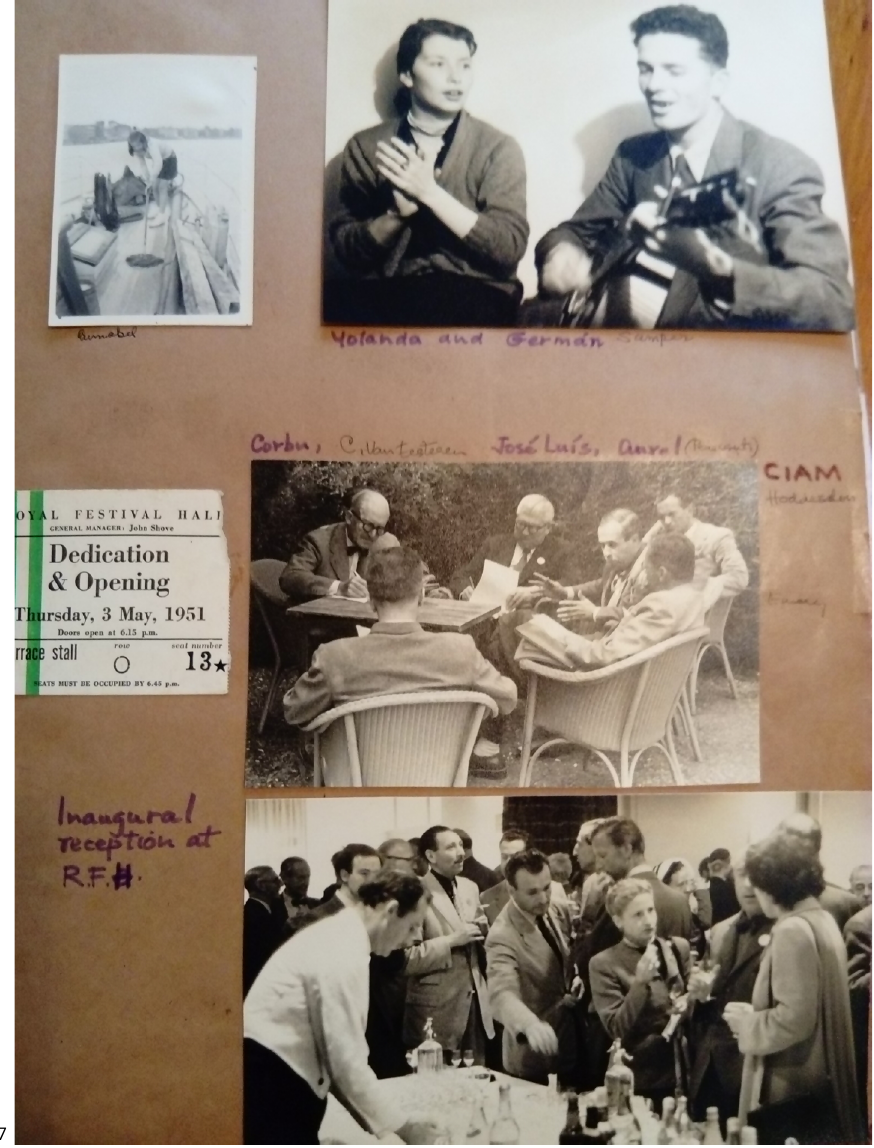
Photographs from 1951 in Monica’s scrapbook (permission courtesy of Annabel